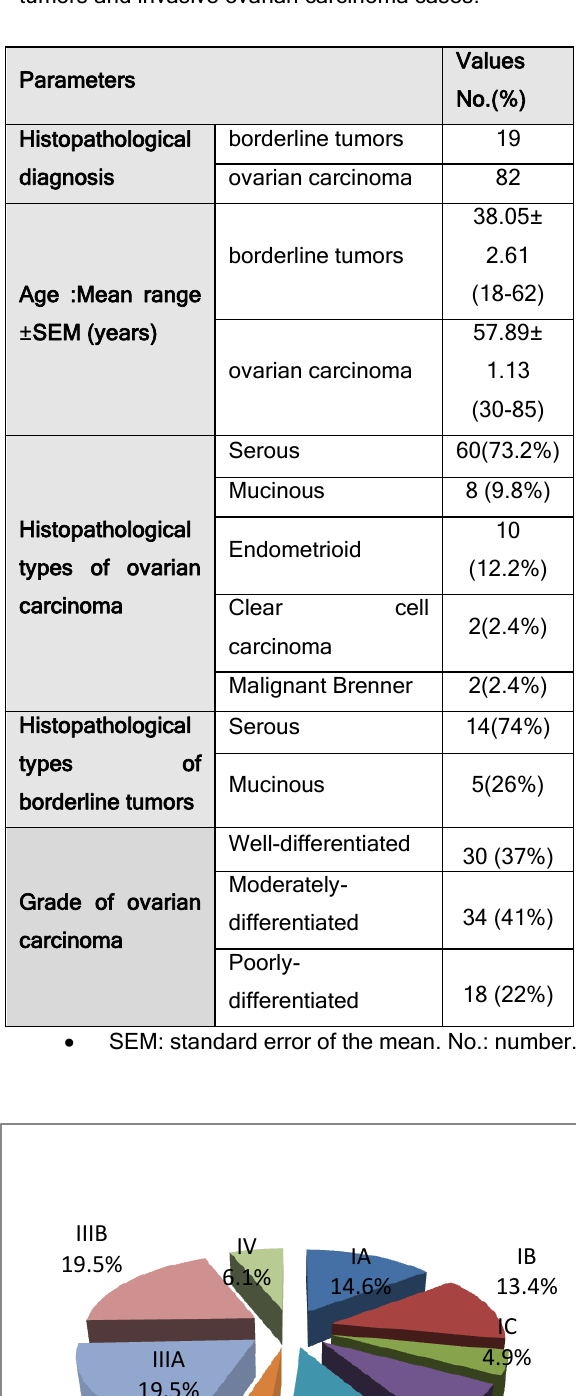
FIGO: International Federation of Gynecology